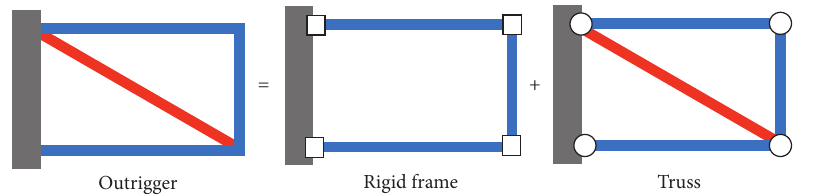
Figure 5: Simplified mathematical model of outriggers